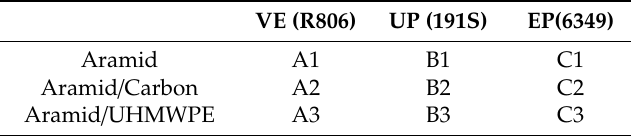
Table 4. Sample code symbols.